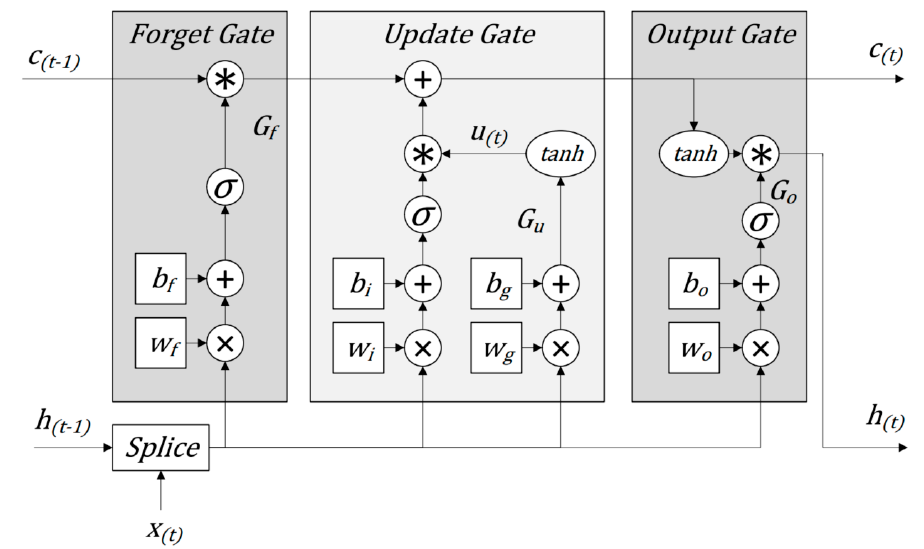
Figure 3. LSTM Unit Structure.